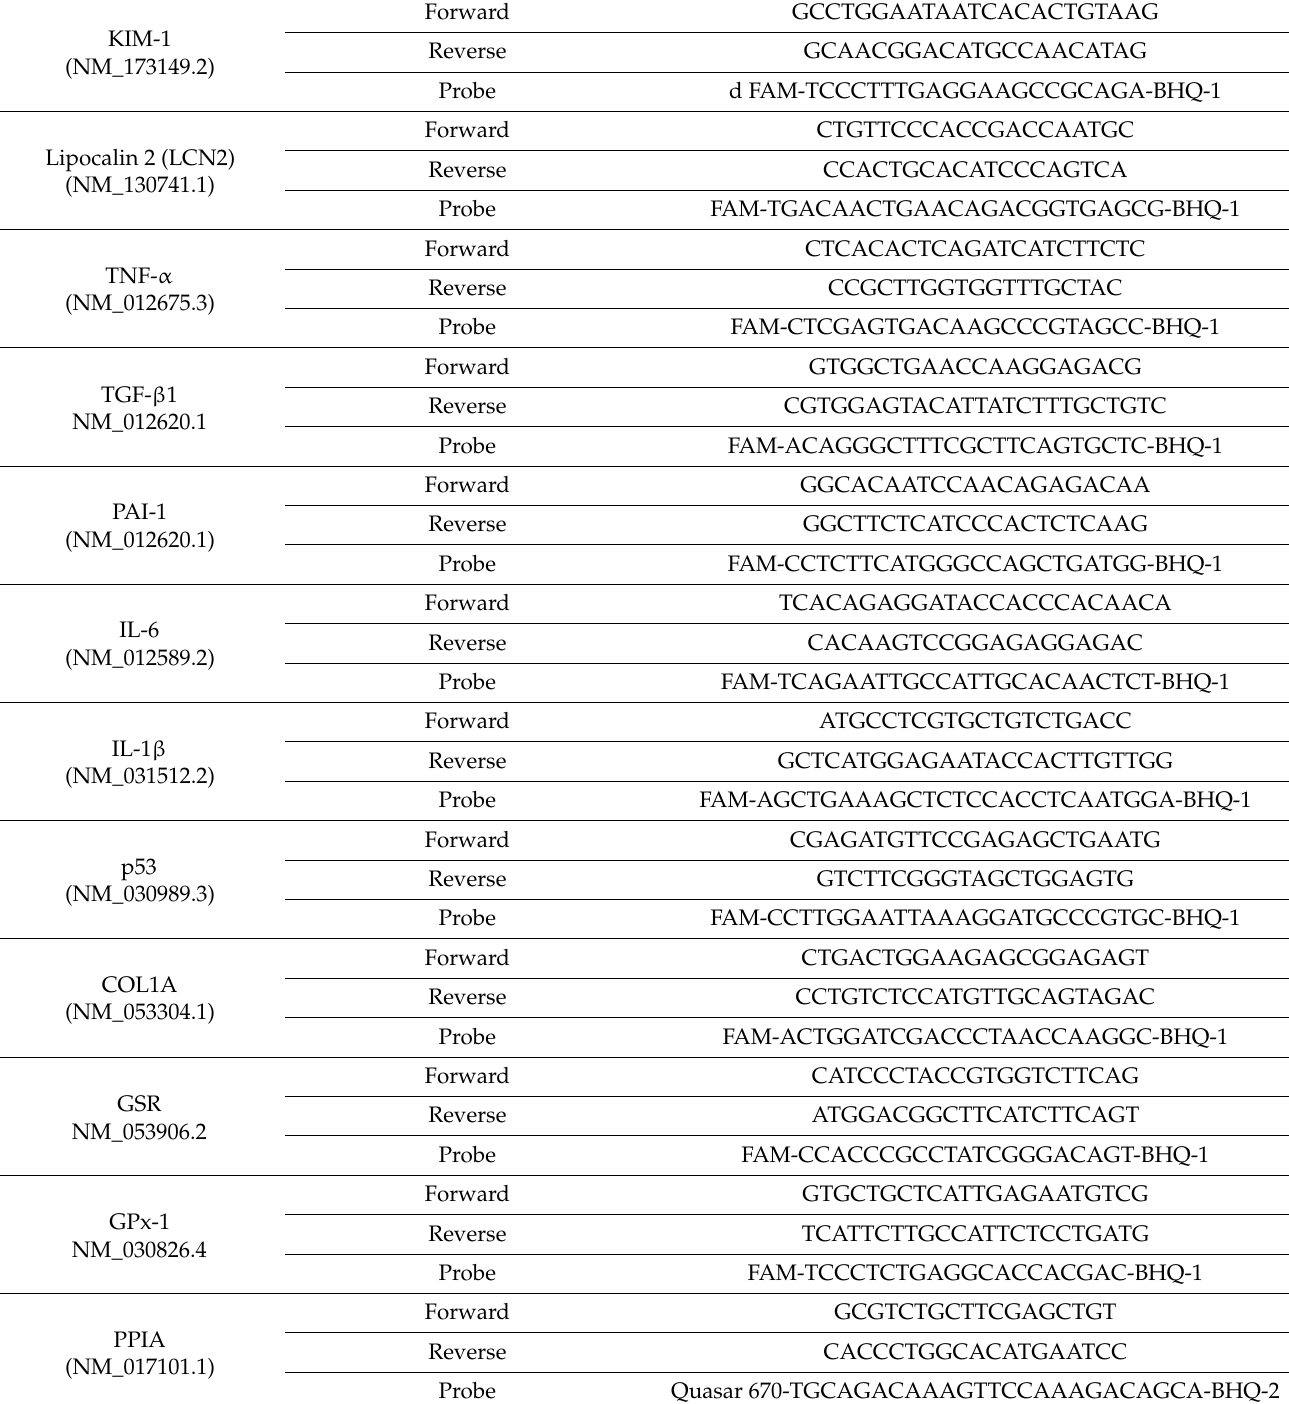
Table 1. Forward and reverse primers and fluorogenic probe sequences used for real-time quantitative PCR analysis. KIM-1: kidney injury molecule-1; NGAL: neutrophil gelatinase-associated lipocalin, also called lipocalin 2 (Lcn2); TNF- α : tumor necrosis factor-alpha; TGF- β 1: transforming growth factor- β ; IL-1 β : interleukin 1 beta; IL-6: interleukin 6; TGF- β 1: transforming growth factor- β ; PAI-1: plasminogen activator inhibitor-1; p53: proapoptotic gene p53; COL1A: procollagen type-1; GSR: glutathione-disulfide reductase; GPx-1: glutathione peroxidase 1; PPIA: peptidylprolyl isomerase A (housekeeping